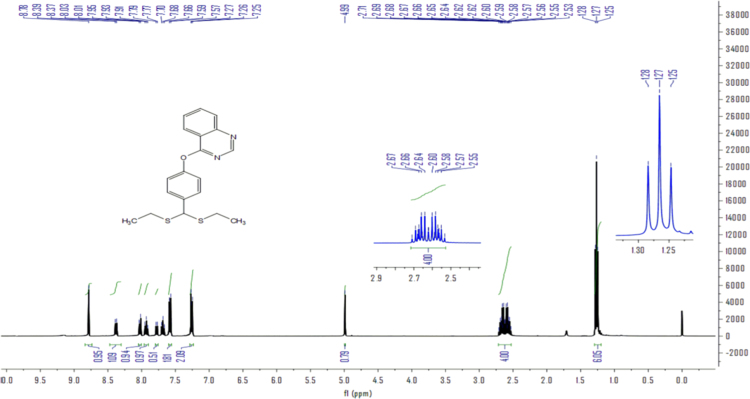
1H NMR of Compound 4a.